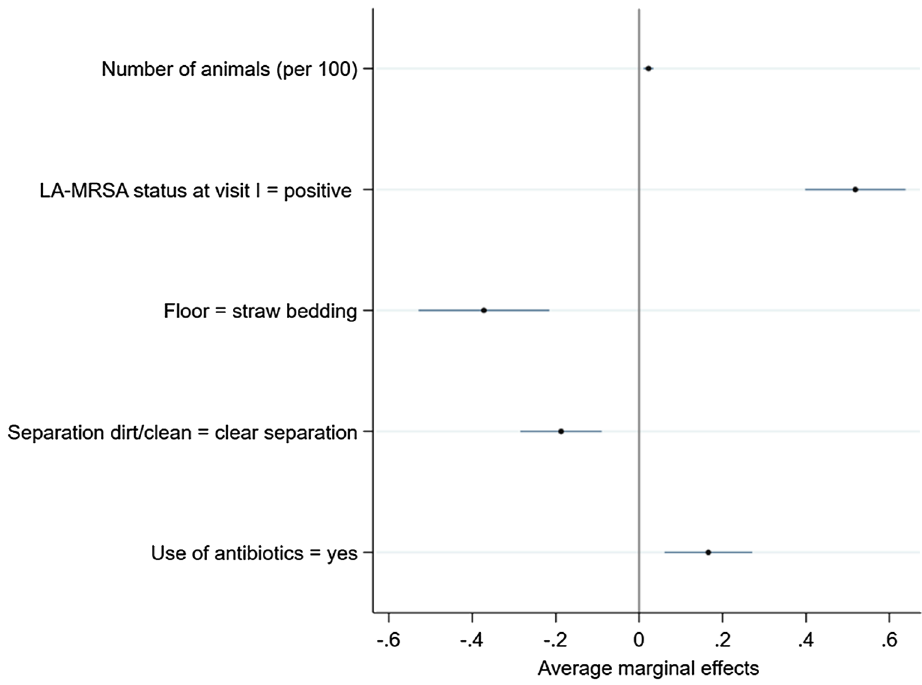
Figure 4. Estimated average marginal effects (points) with 95% CI (lines) of the independent variables on the probability of being LA-MRSA positive at visit